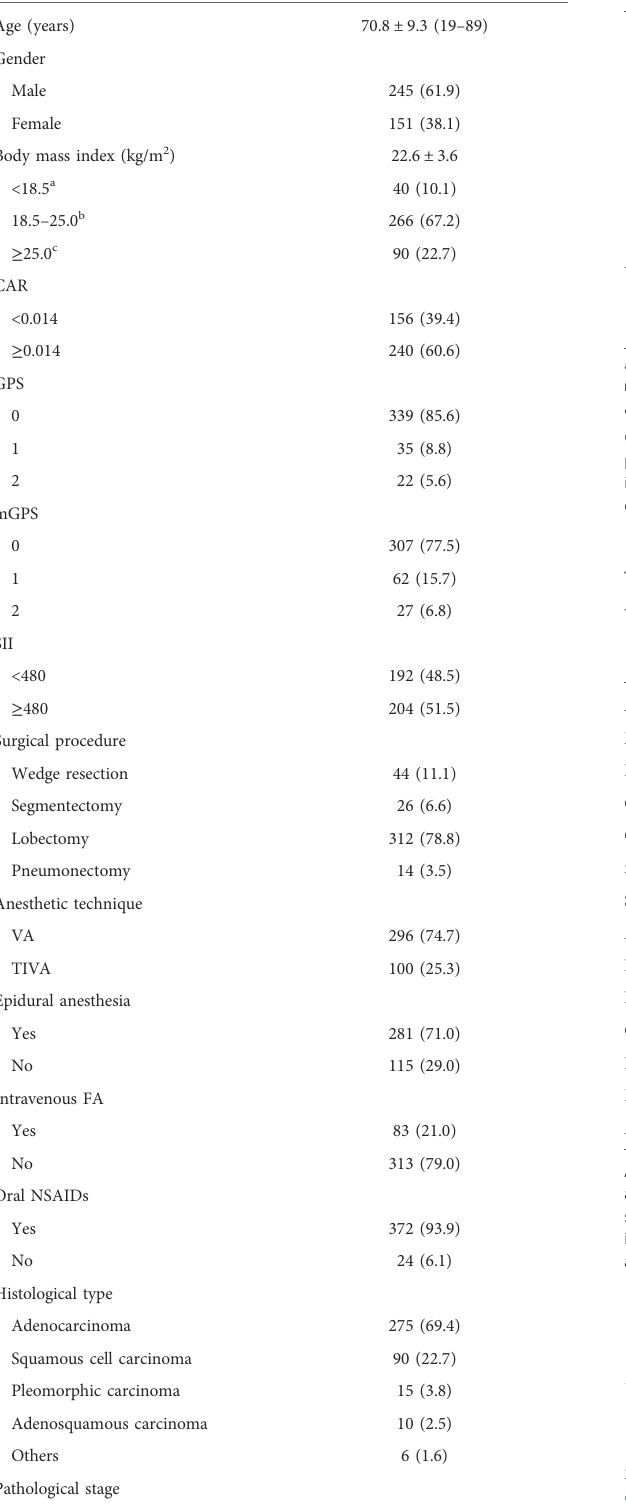
In total, 118 (29.8%) patients developed recurrence. The results of a multivariate Cox analysis of the RFS are given in Table 2 . The anesthetic technique ( P = 0.031), CAR ( P = 0.008), and pathological stage ( P < 0.001) were suggested as independent prognostic factors.